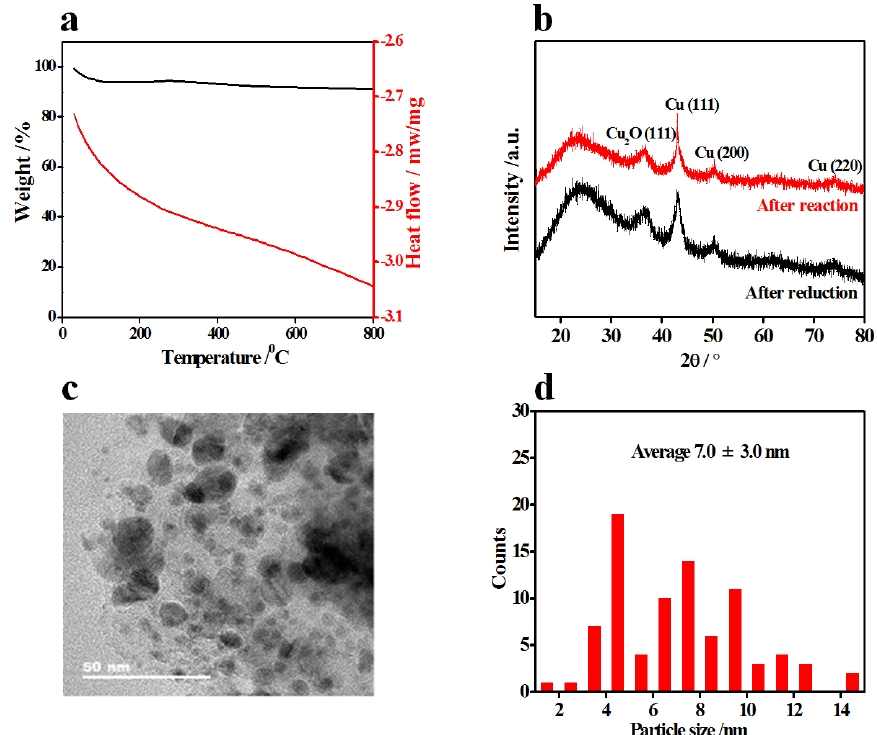
Figure 8. Characterization results of the spent 25Cu–ASA-4 catalyst after SRD for a TOS of 6 h. ( a ) TG-DSC patterns; ( b ) XRD profiles of the reduced and used catalyst; ( c ) TEM image; ( d ) particle size distribution.